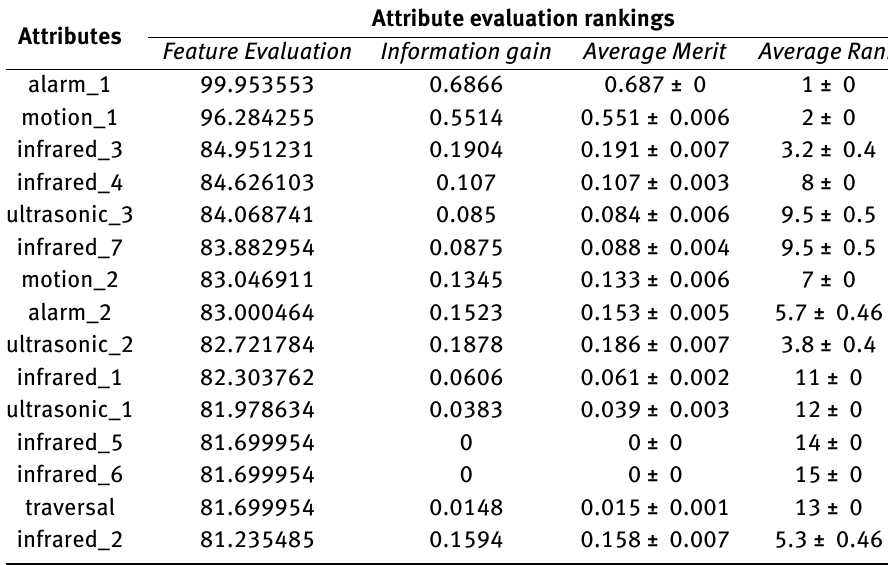
Table 6: Attribute Evaluation and Information Gain Rankings of X80-H in Position 2 Determining Presence